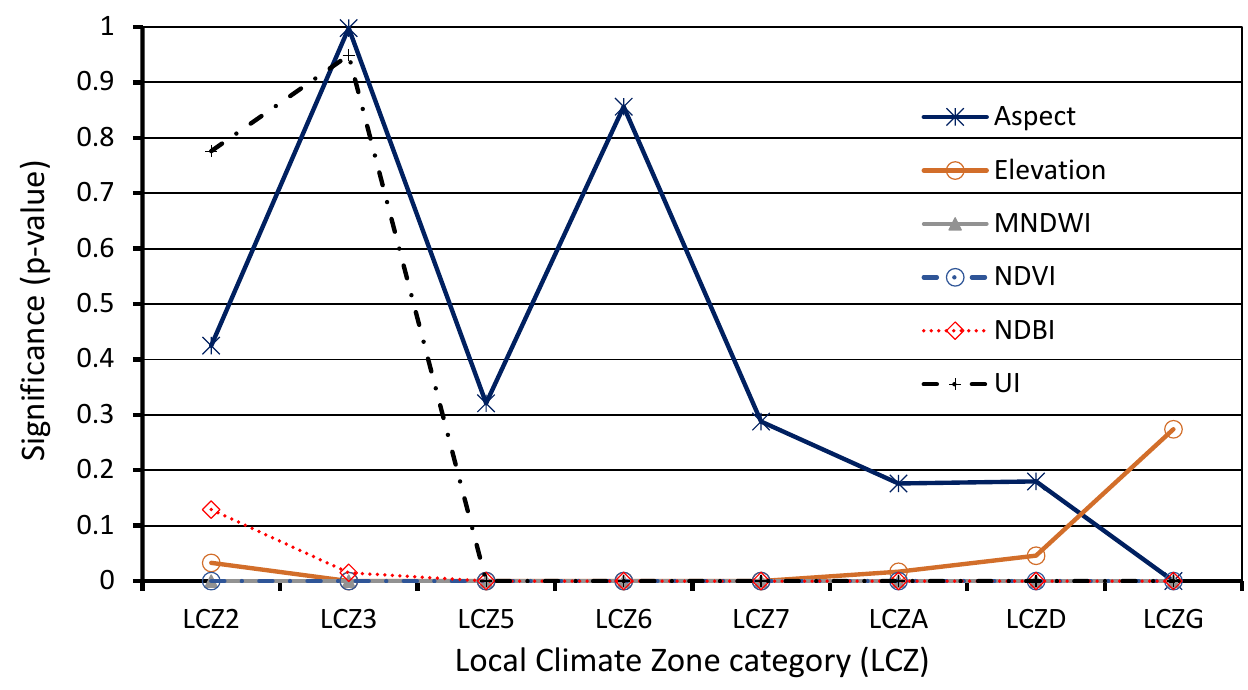
Figure 8. Significance of the correlations of factors with LST per LCZ.